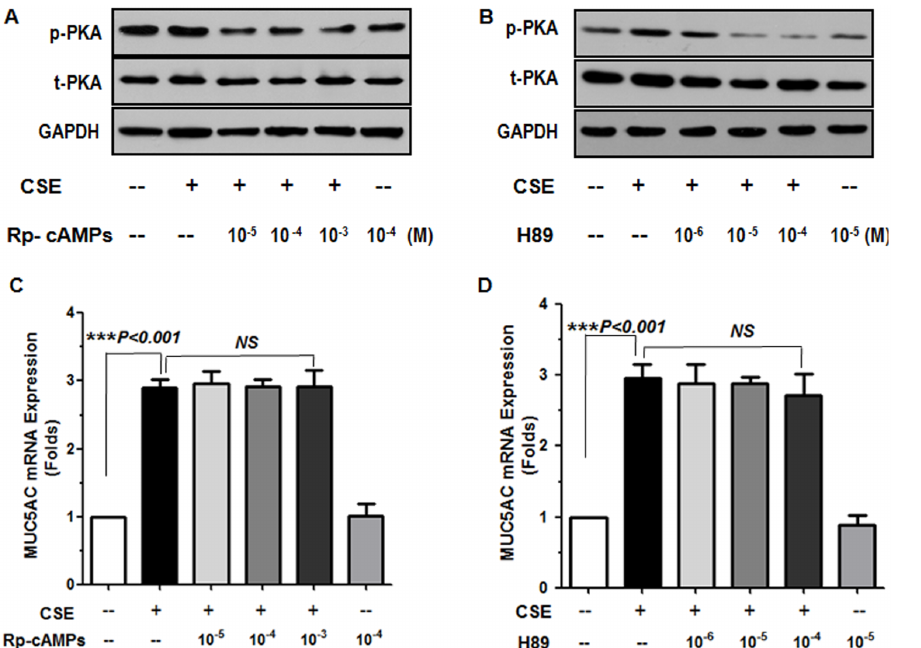
Figure 3. Effect of cAMP–protein kinase A (PKA) inhibition on CSE-stimulated MUC5AC expression. Western blot analysis of phospho- PKA (p-PKA) and total PKA (t-PKA) levels in cells preincubated with (A) Rp-8-Br-cAMPs or (B) H89 for 30 min before stimulation with or without CSE for 15 min. (C, D) RT-PCR analysis of MUC5AC mRNA expression after incubation with or without CSE for 24 h. Data are means 6 SEM from 3 separate experiments. *** P , 0.001 compared to CSE alone. NS, not